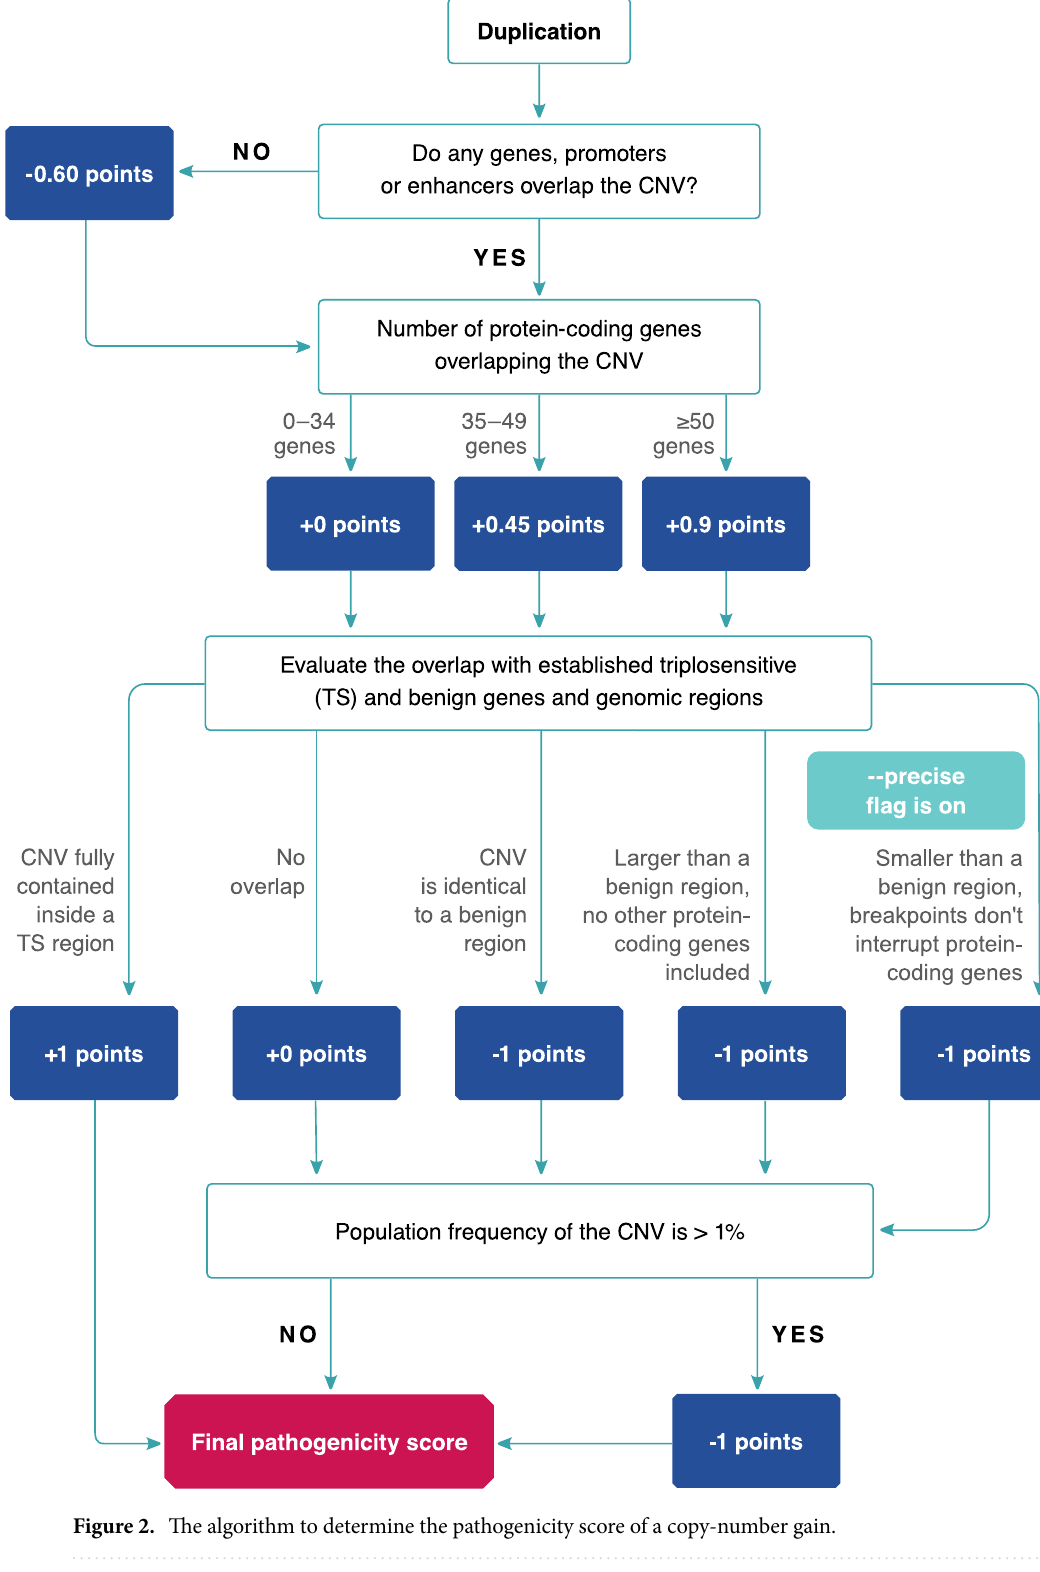
Figure 2. The algorithm to determine the pathogenicity score of a copy-number